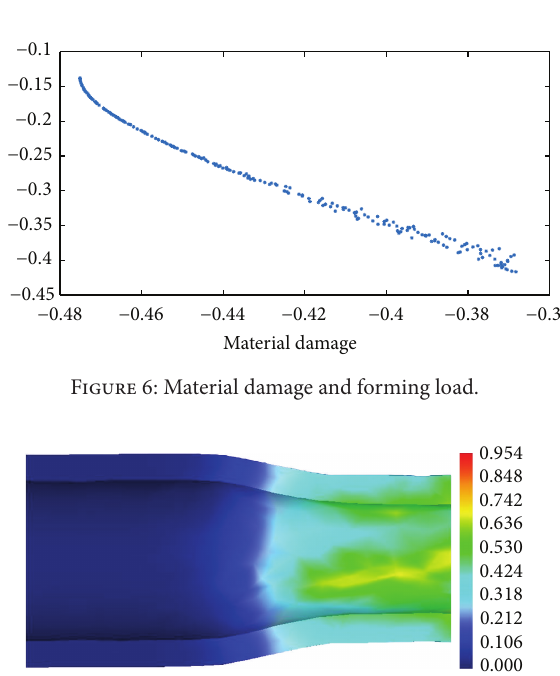
Figure 5: Deformation homogeneity and forming load.